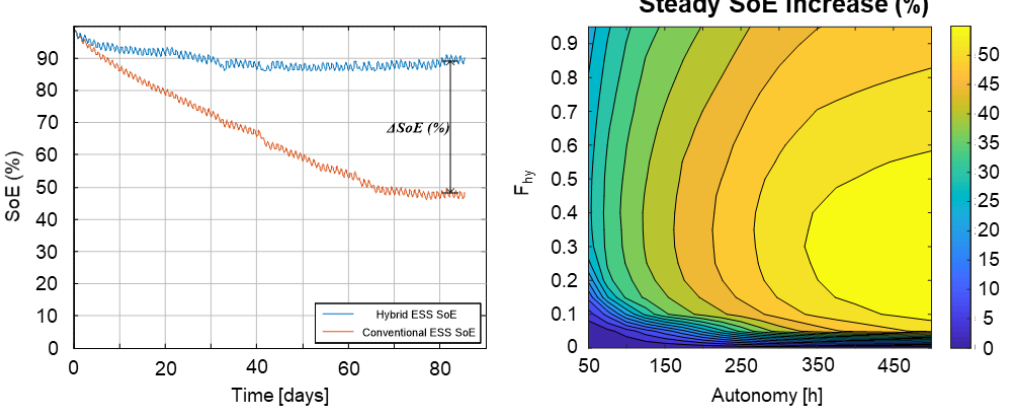
Figure 10. Sample Steady SoC increase ( a ), Steady SoE increase map ( b ). Figure 10 . Sample Steady SoC increase ( a ), Steady SoE increase map ( b ).